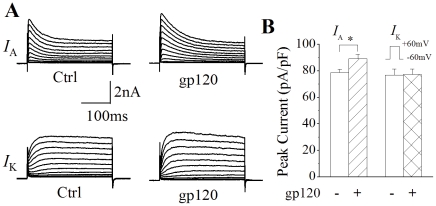
Enhancement of I
A by gp120.A shows representative current traces recorded in control (Ctrl, left) and gp120-treated (gp120, right) rat cortical neurons in the presence of TEA (20 mM, upper) and 4-AP (5 mM, lower). The voltage protocol utilized to generate outward K+ currents were the same as shown in Fig. 1A. Note that gp120 enhanced I
A (upper) with no apparent effect on delayed rectifier like I
K (lower). B is a summarized bar graph illustrating gp120 enhancement of the I
A, but not the I
K. Each value represents the mean ± SEM. * p<0.05; gp120 (n = 115) vs Ctrl (n = 128) for I
A. p>0.05; gp120 (n = 35) vs Ctrl (n = 30) for I
K.